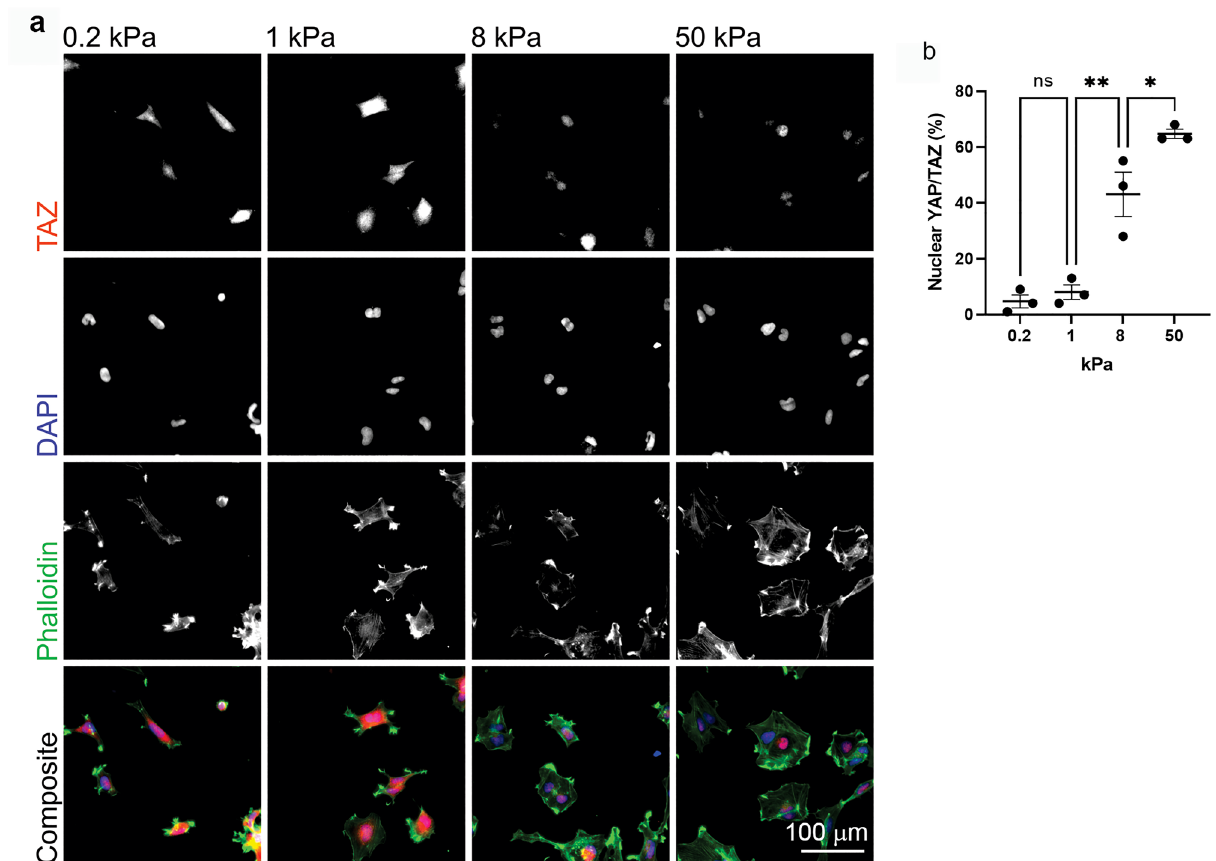
Figure 2. YAP/TAZ nuclear accumulation is regulated by substrate rigidity. ( a ) WK1 cells cultured on matrix- coupled PAGs, immunostained with anti-TAZ antibodies, DAPI to detect nuclei and phalloidin to detect F-actin. ( b ) Quantification of YAP/TAZ nuclear accumulation relative to substrate stiffness. Each data point shows the average score from 3 blinded scorers (details in methods). Symbols denote statistical significance: **** **p < 0.01; *p < 0.05; NS = not significant; One-way ANOVA with Tukey’s post-comparison test. Error bars indicate